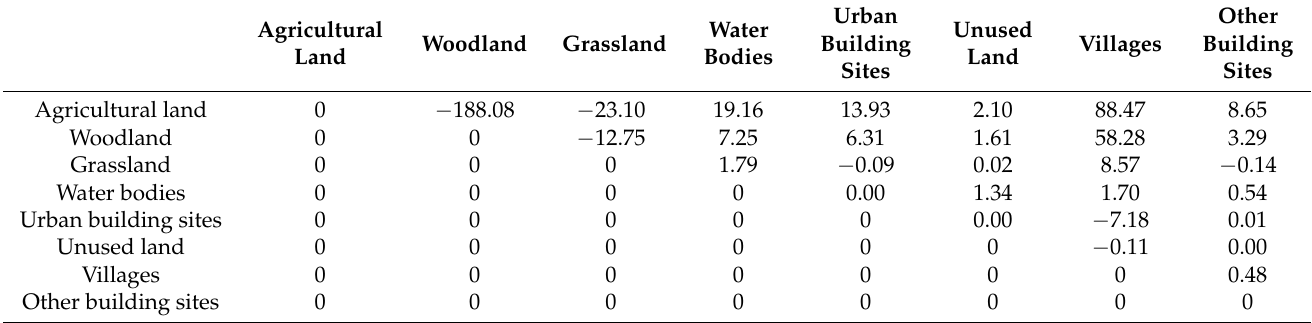
Table 8. Net land use transfer matrix between [10, Max] km buffer zone in Dalian. Agricultural